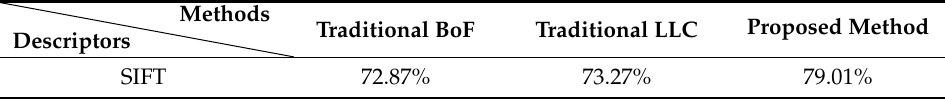
Table 1. Classification accuracies based on Scale Invariant Feature Transform (SIFT).